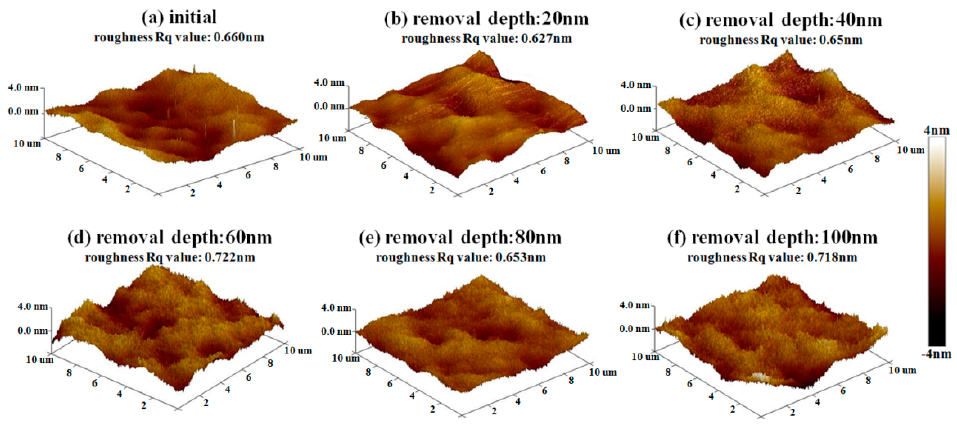
Figure 8. Morphology evolution of sample #1 in EJP postprocessing.